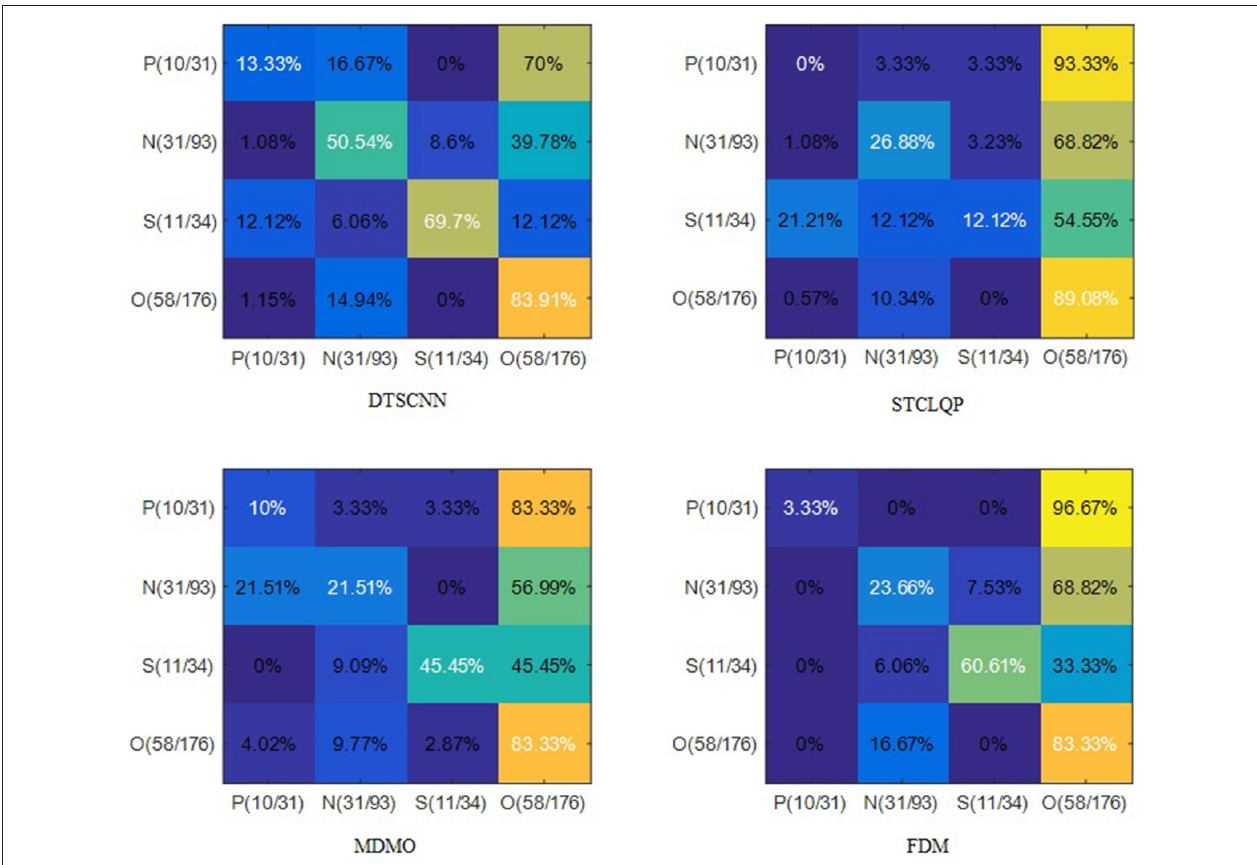
FIGURE 7 | Confusion matrices on CASMEI/II dataset. The N, O, P, and S denote the classes of Negative, Others, Positive, and Surprise, respectively. The number in packets indicates the number of samples in testing set vs. the training